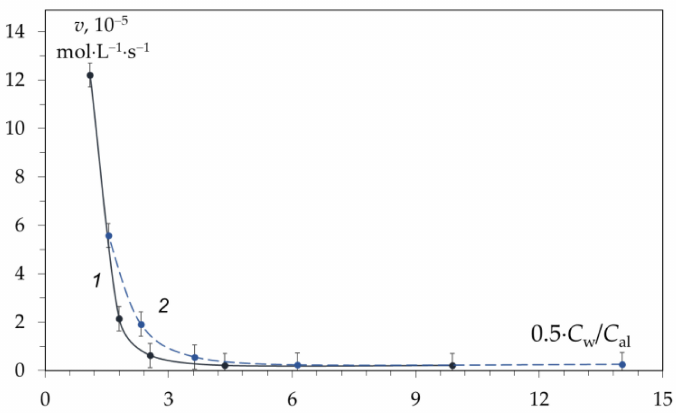
Figure 13. Dependence of the rate of the deacetylation reaction in the first section of the kinetic curve during the deacetylation time of 0–10 min at 100 ◦ C in a solution of NaOH (1) and KOH (2) on the number of water molecules per one ion of dissolved hydroxide. Original